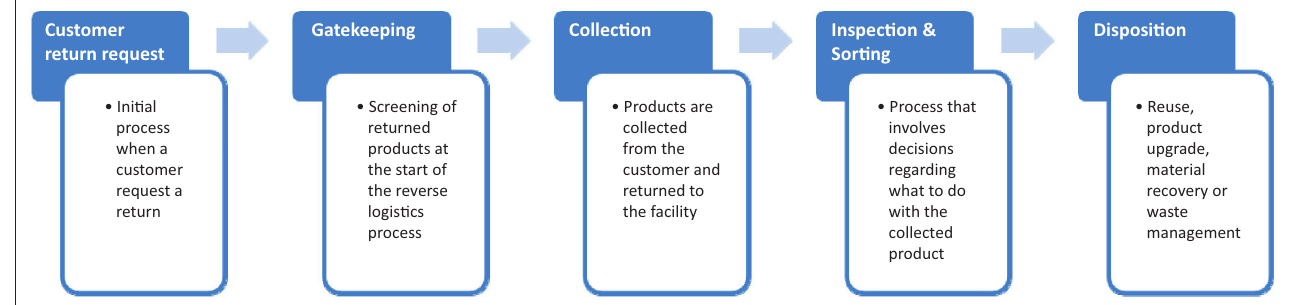
FIGURE 1: Reverse logistics process activities.